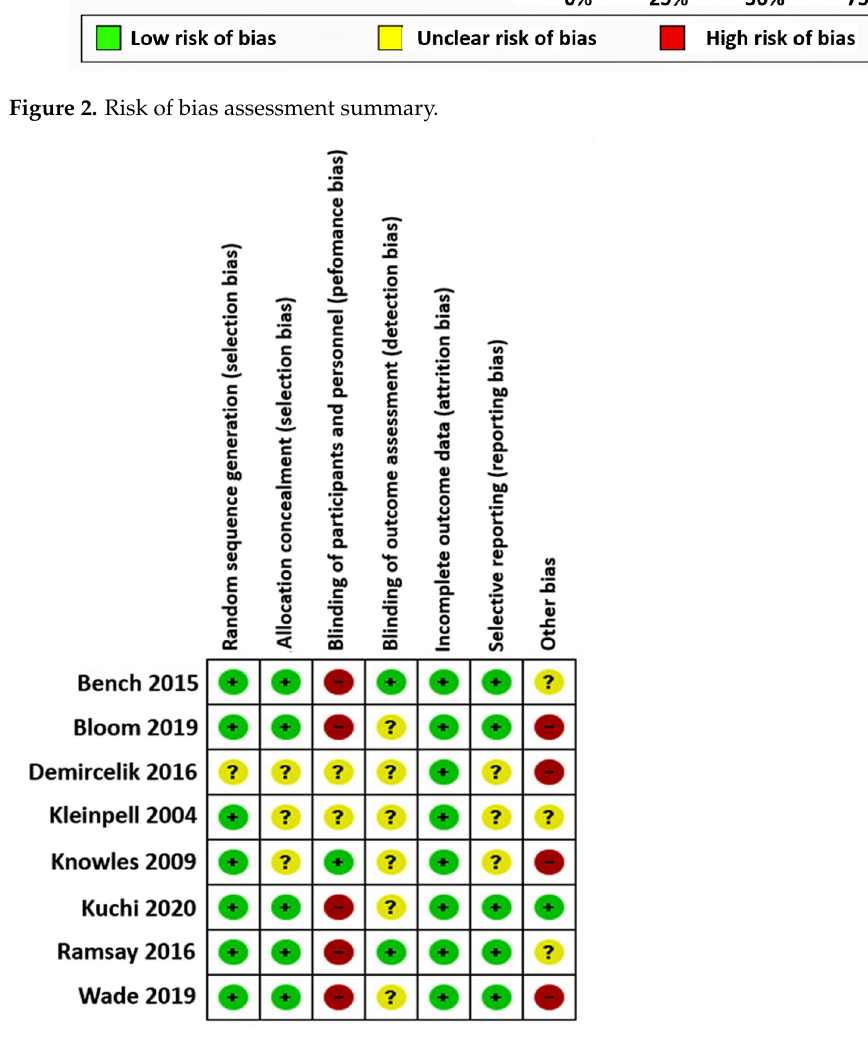
Figure 3. Quality assessment of studies included.